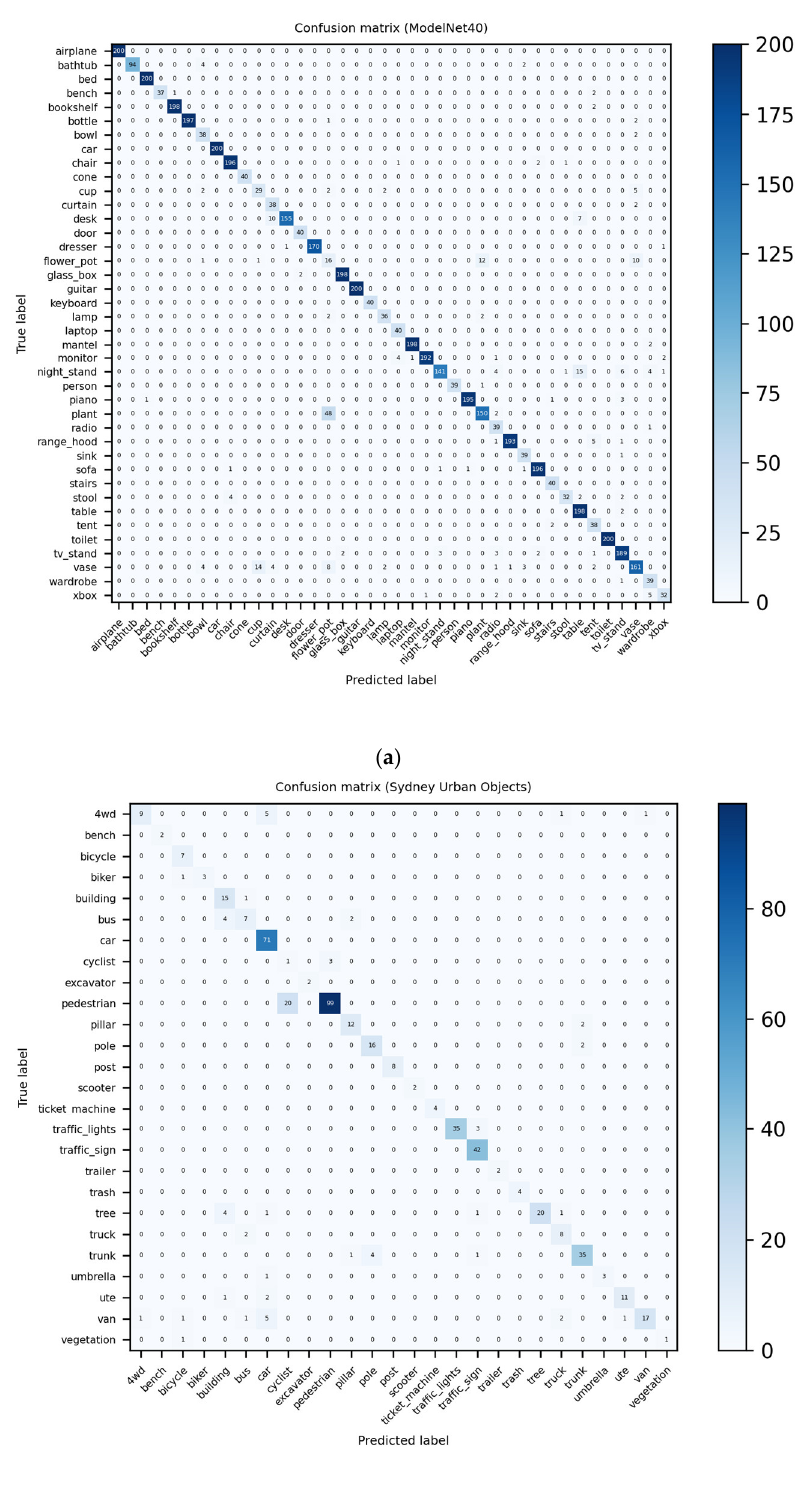
Figure 9. Confusion matrices for all categories of the two datasets. ( a ) ModelNet40. ( b ) Sydney Urban Objects.